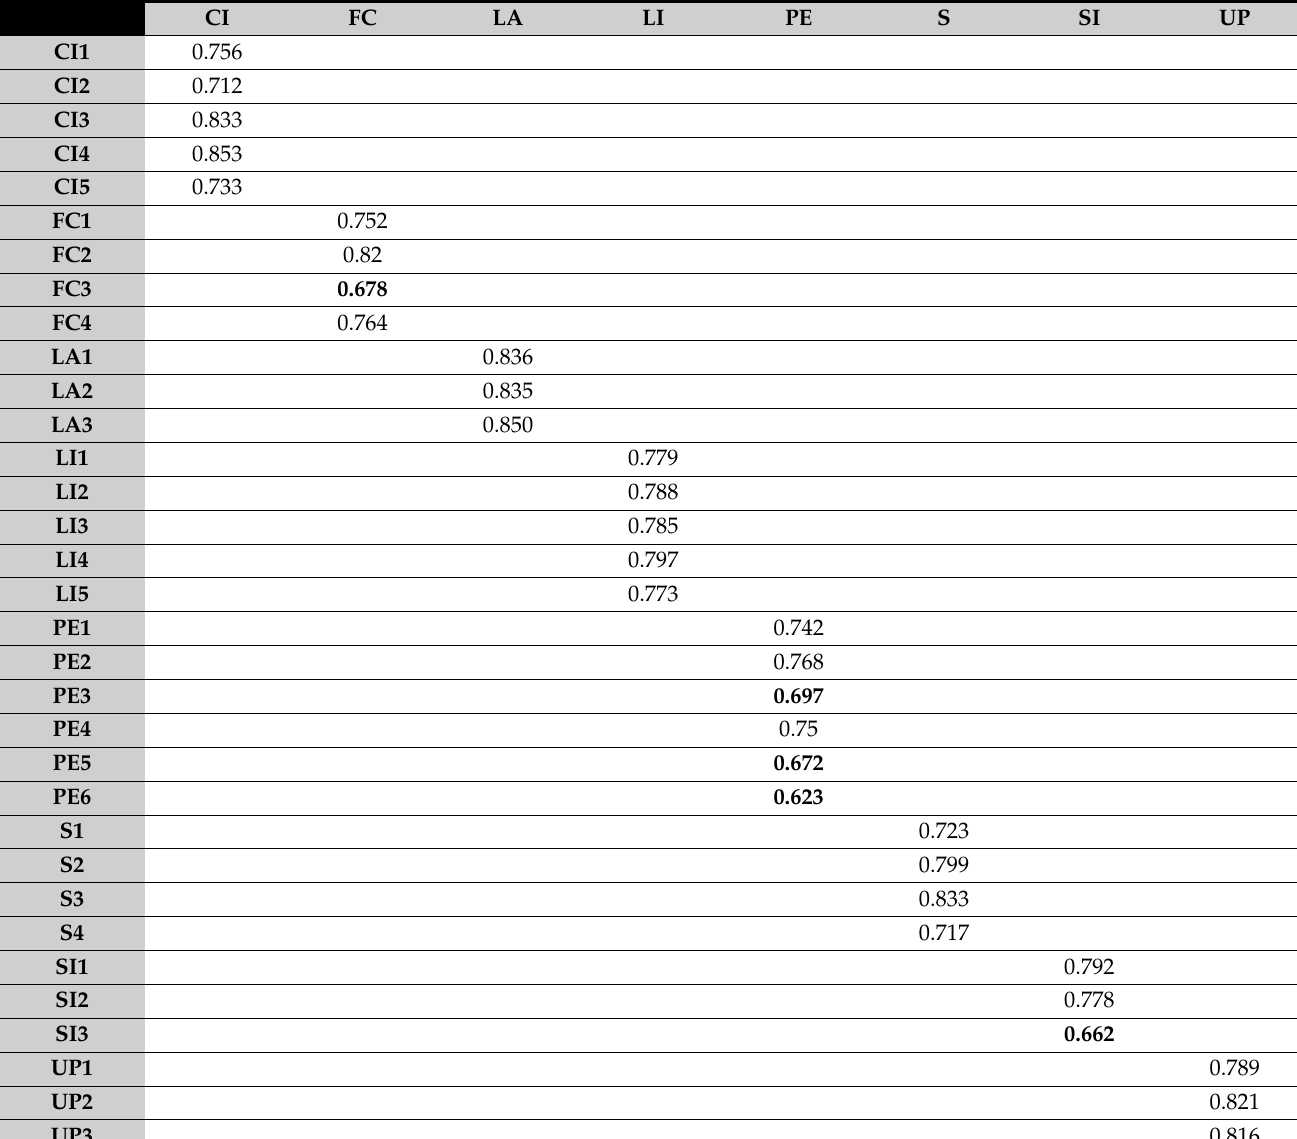
Table 7. Loading Factor.